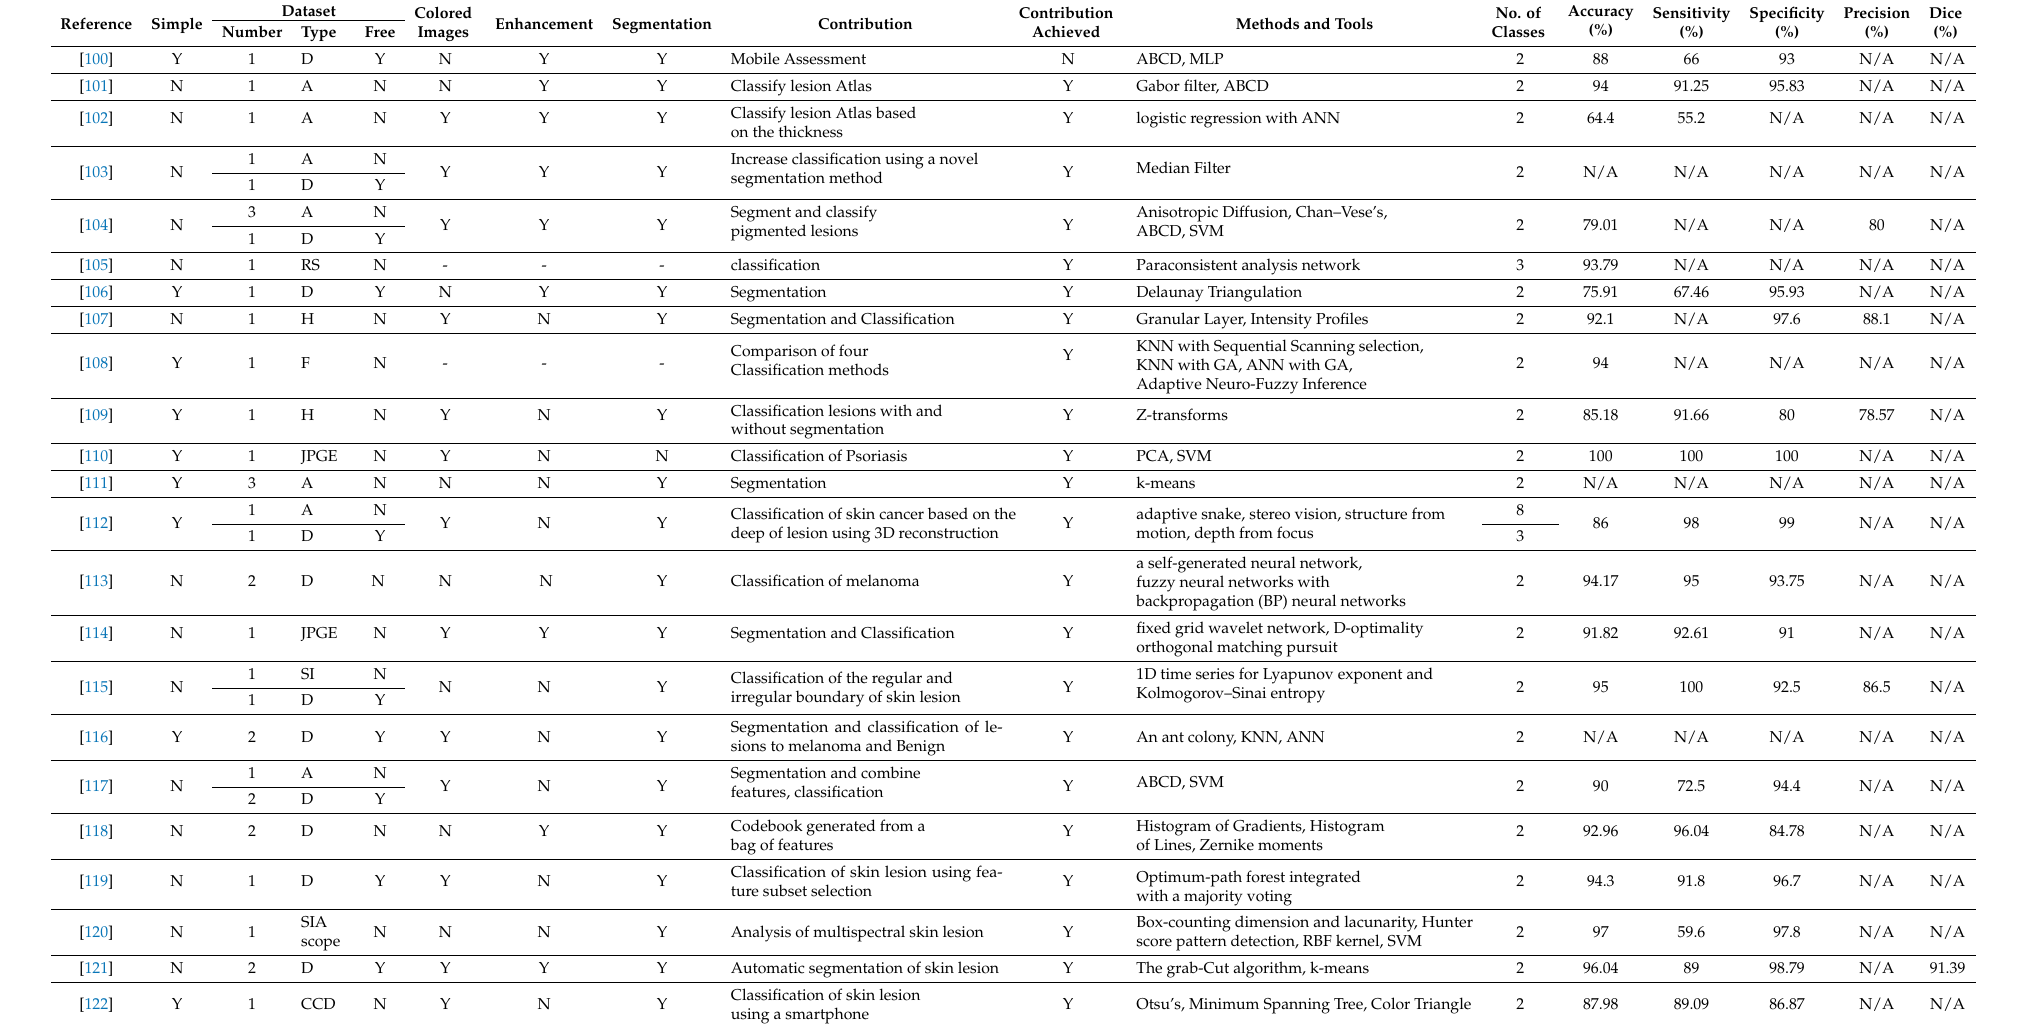
Table 2. A comparison between state-of-the-arts methods with novel methods.